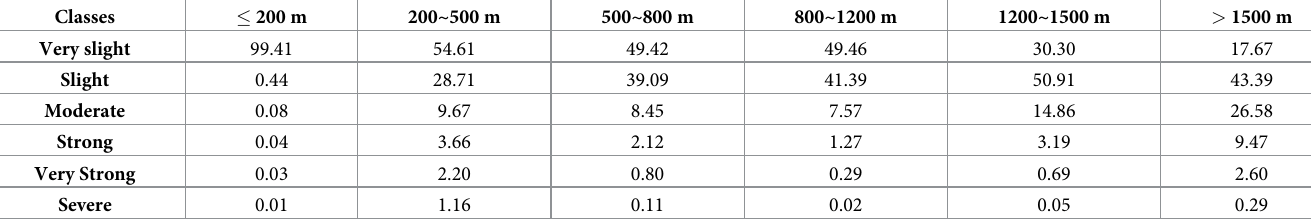
land was very slightly eroded, and soil erosion occurred in 71.45% of the total area. Further- more, they found that soil erosion of woodland and grassland was slight, accounting for 35.52% and 33.23% of the area, respectively [61]. This is consistent with the areas that experi- enced slight erosion of arable land (64.38%), woodland (32.42%), and grassland (34.17%) of this study. Soil erosion is more serious in the forested and grassland areas of the Qin River Basin, due to the fact that grassland and forested land are mostly distributed in high-elevation areas with large topographic relief, where the potential soil erosion is larger and the soil ero- sion intensity is higher. Among the secondary land types, soil erosion is more serious in sparse forest land and forested land; soil erosion is more serious in high cover grassland and medium cover grassland. Therefore, the specific land use types can be adjusted in the Qin River Basin in terms of erosion control and land use management, and the area share of other woodlands, shrublands and low-cover grasslands can be increased. Zhang et al. suggested that effect of slope on soil erosion is unique rather than displaying a proportional relationship [30]. Rao et al revealed that areas with a slope of 15–25˚ were the most severely eroded in China [62]. Similarly, the soil-erosion degree in this study area increased as the slope increased and the degree of soil erosion increased. A slope limit of 15˚ affects soil erosion. The areas with a slope of > 15˚ accounted for 47.57%, while the proportion of soil erosion in such areas was 64.99%. These results are similar with the results of Jiang et al. in the Jinsha River [63]. Wang et al. showed that the critical values of soil erosion are different for different geomorphic patterns [64]. With an increase in altitude and gradient, soil erosion first increases and then decreases, and the critical range of the most serious erosion varies for different research scales and locations. Rao et al. found that, in China, areas with an altitude of 1000–2000 m are of serious concern in terms of soil erosion. This is similar with the concern areas consisting of regions with an altitude of > 1200 m [62]. The greater the slope and undu- lation, the greater the instability of the soil on the slope, and the greater the possibility of